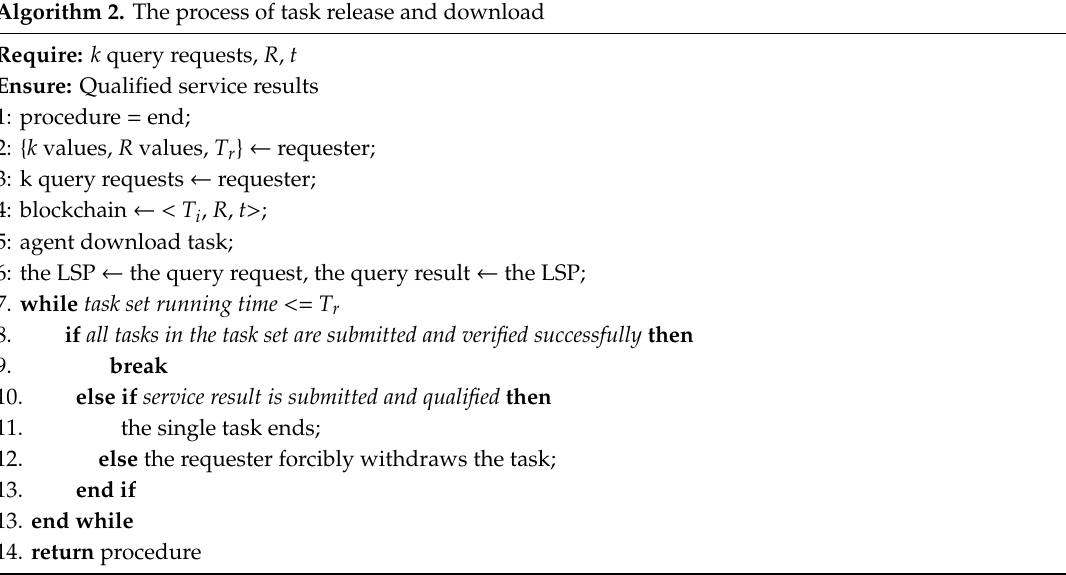
Algorithm 2. The process of task release and